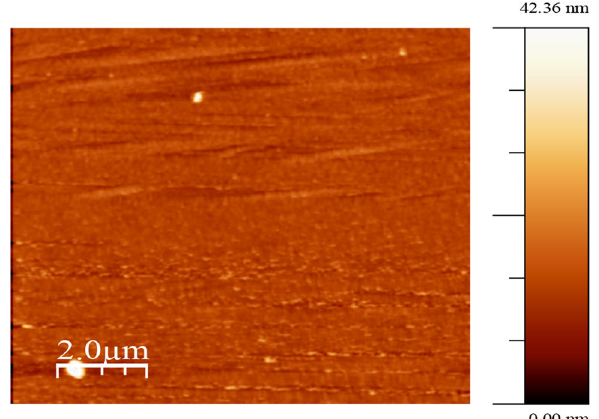
Figure 1. AFM topography of film prepared at 300 W power, 3sccm oxygen flow and 6.0mTorr pressure.